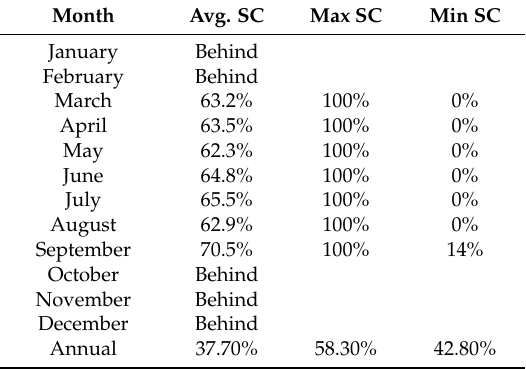
Figure 6. Sun path diagram of Jakarta (Autodesk Ecotect Weather Tool Software) [47]. Table 15. Effective shading coefficient (SC) in a south ‐ facing building in Jakarta (Autodesk Ecotect Table 15. Effective shading coefficient (SC) in a south-facing building in Jakarta (Autodesk Ecotect Solar Tool Software 2011) [48]. Solar Tool Software 2011)